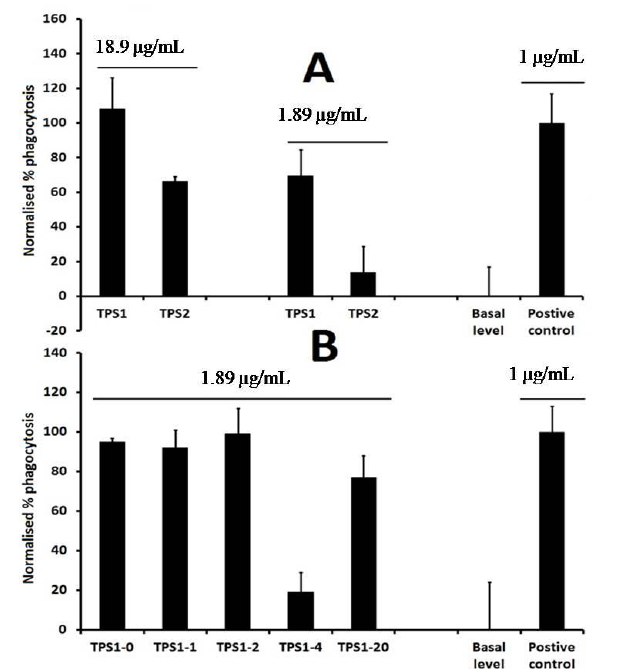
Figure 2. Phagocytic activity of ( A ) TPS1, TPS2 (18.9 or 1.89 μg/mL) and ( B ) sub-fractions of TPS1 (1.89 μg/mL). Positive control (LPS, 1 μg/mL).